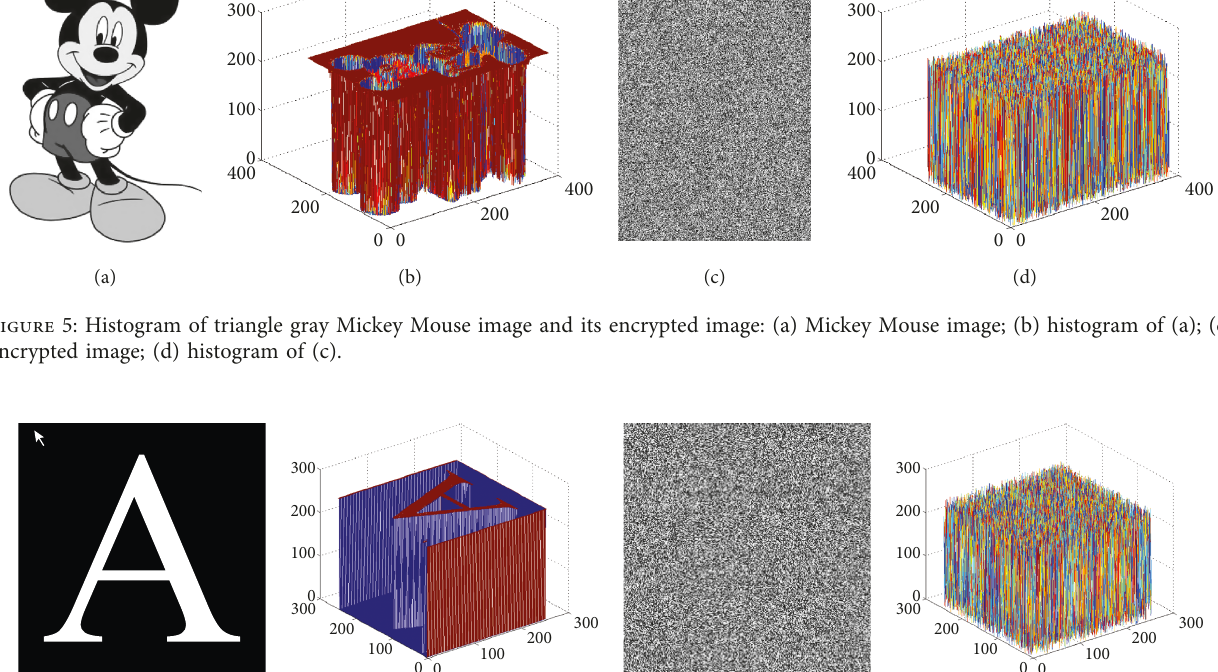
images. Table 1 indicates that the performance of the proposed algorithm is better. Therefore, the proposed encryption algorithm dramatically randomized the pixels.